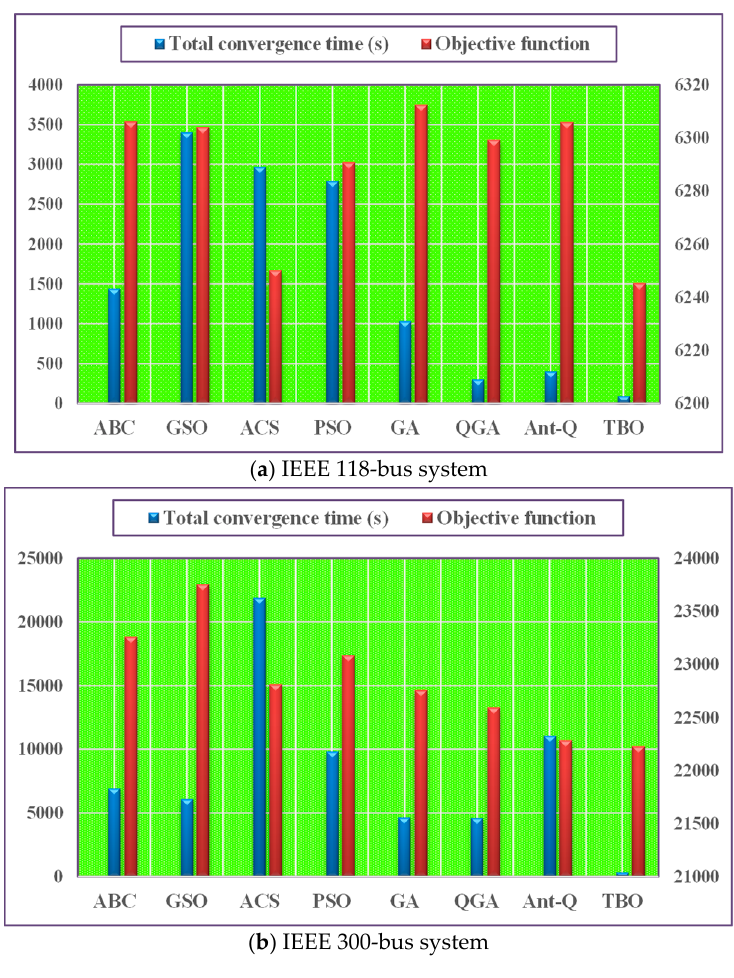
Figure 10. Comparison of performance of different algorithms obtained in 10 runs. Table 2. Performance indices results of different algorithms on the IEEE 118-bus system obtained in